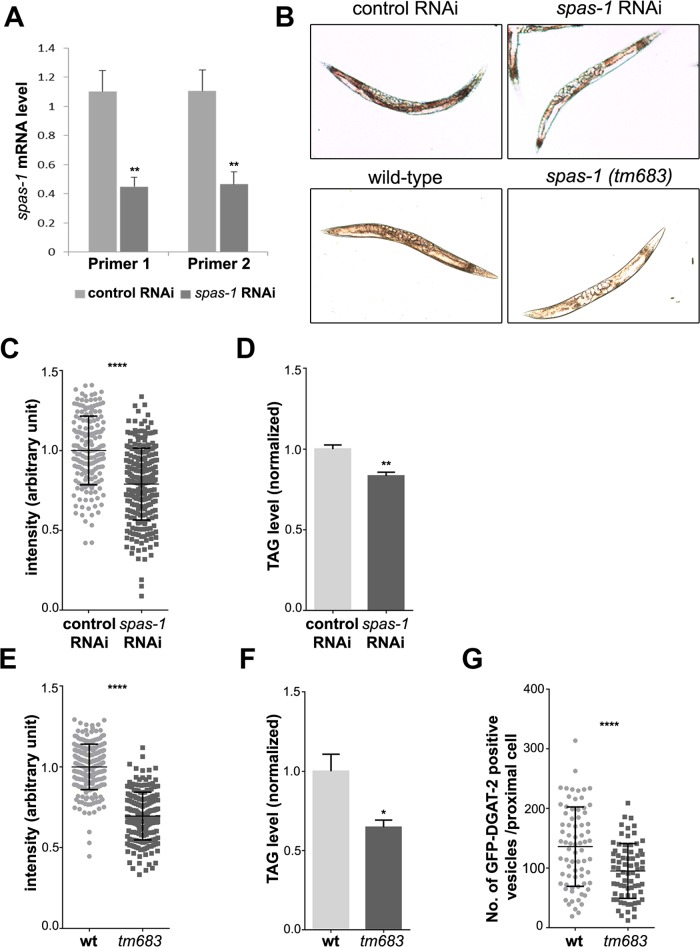

spas-1 knockdown or deletion reduces neutral lipids in C. elegans.(A) spas-1 was efficiently downregulated. mRNA level of spas-1 from three independent biological replicates was determined using two different RNAi oligonucleotides pairs. (B) Representative images (worms with signal intensity matching the median value) of control and spas-1 downregulated (upper panel) and wild-type and spas-1 (tm683) mutant (lower panel) animals stained with oil red O and imaged by DIC. (C and E) Oil red O staining is reduced upon treatment with spas-1 RNAi or in spas-1 (tm683) mutant animals. These quantitative measurements were performed on three independent biological replicates (each measured in duplicate for RNAi and in triplicate for wild-type and mutant; control RNAi = 178, spas-1 RNAi = 256, wild-type = 227, tm683 = 205 animals). The experiment was repeated, showing comparable results. (D and F) Biochemical quantification of TAG levels. Results shown are means ±SEM for three (D) or six (F) independent biological replicates. Data are normalized to the respective control. TAG determination was repeated for each condition, with similar results. (G) Wild-type or spas-1 (tm683) mutant animals crossed into hjSi56 background (stably expressing the LD marker GFP::DGAT-2) were imaged on day 1 of adulthood and the number of green fluorescent vesicles in the proximal intestinal cell was determined (wild-type = 74, tm683 = 72 animals). *p<0.05, **p<0.01, ****p<0.0001 (unpaired Student’s t-test).